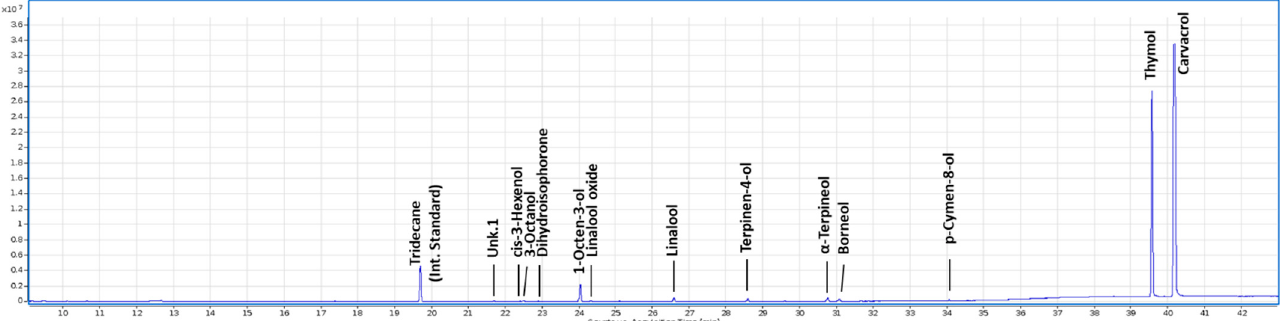
Figure 2. Total ion chromatogram (TIC) of monoterpenes and other volatile organic compounds present in M. didyma HY. present in M. didyma